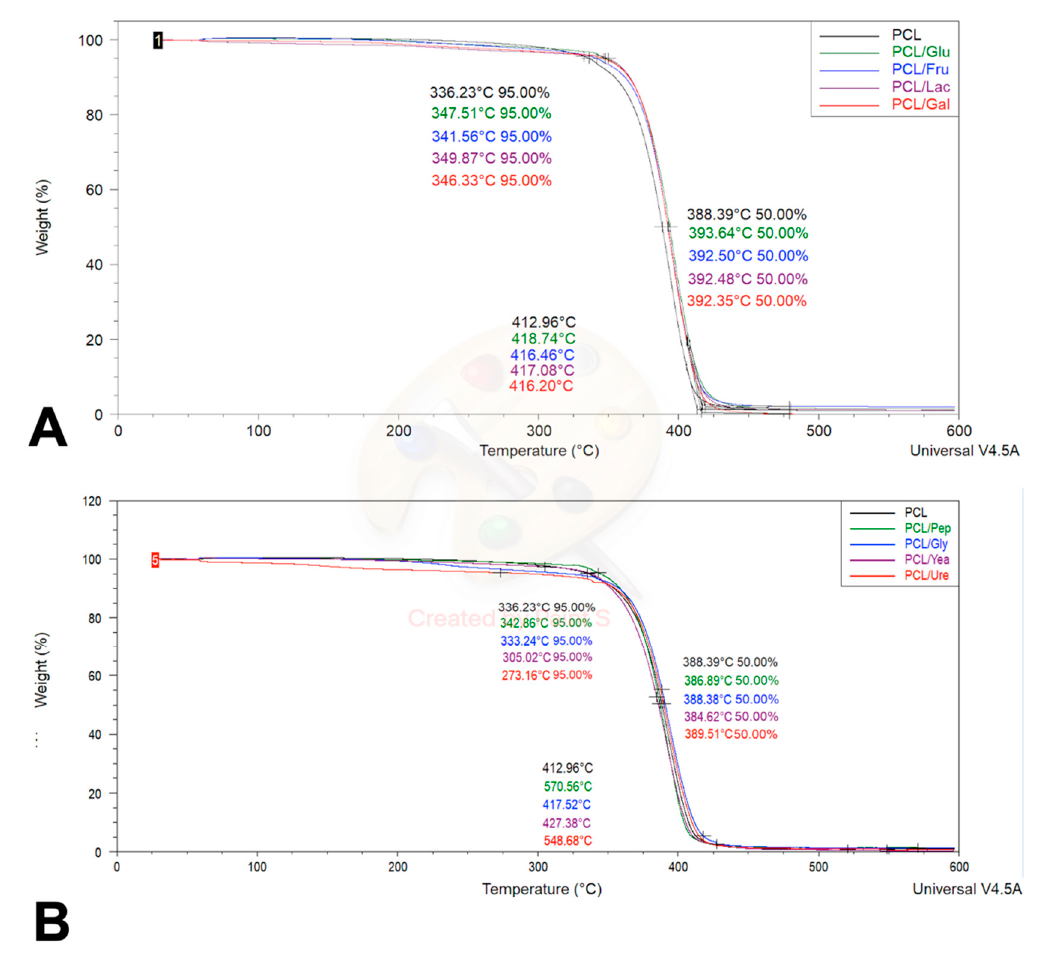
Figure 2. TGA thermogram regarding the weight percentage changes ( A ) PCL/Cs fibers, ( B ) PCL/Ns fibers.